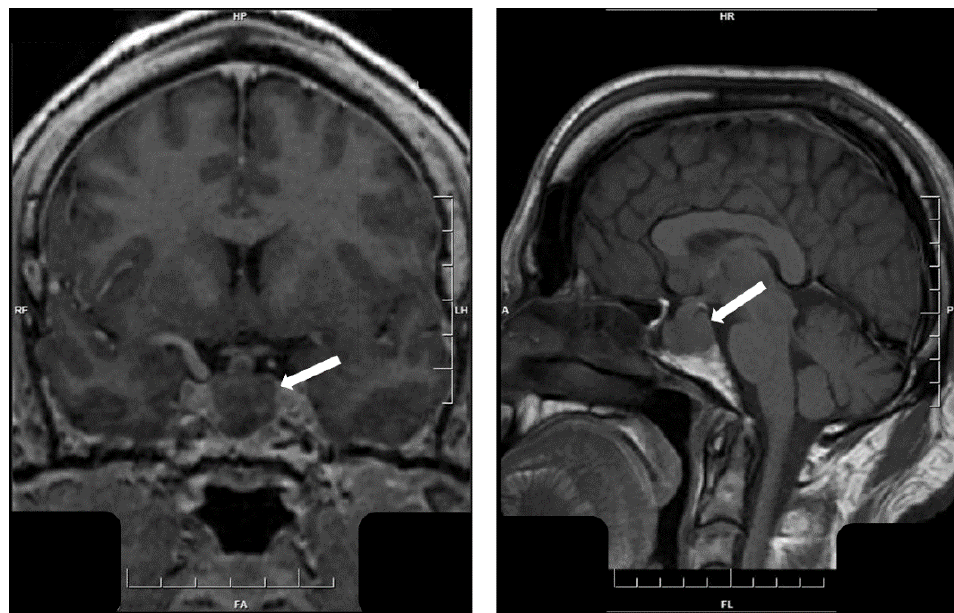
Figure 8. Magnetic resonance imaging of immature PIT1-lineage tumor. This large tumor invades laterally into both cavernous sinuses (arrow, left ) extends upwards, forming a “snowman”-like mass herniating above the diaphragma sella (arrow, right ).